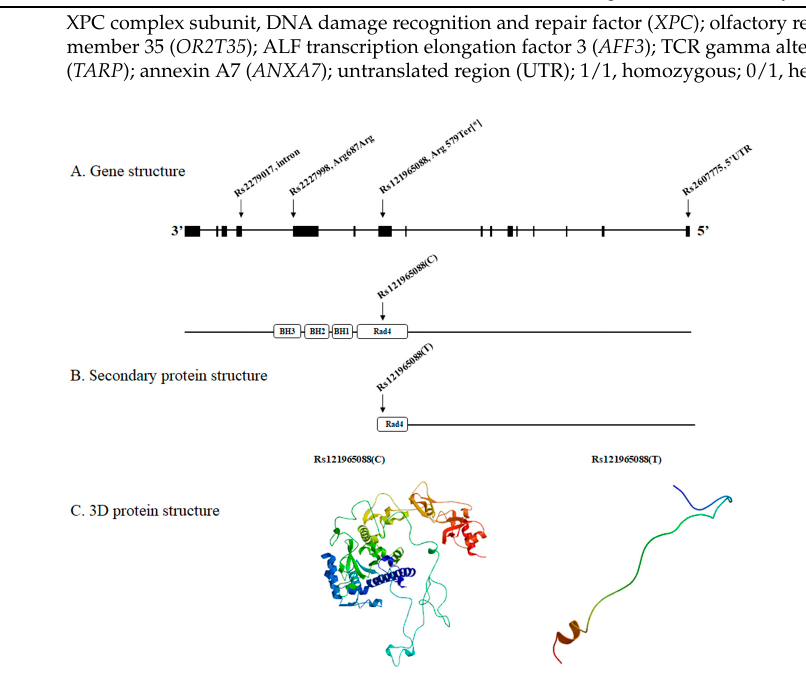
Figure 1. ( A ) The four XPC complex subunit, DNA damage recognition and repair factor ( XPC) variants (rs121965088, rs2227998, rs2279017 and rs2607775) of our patient located on the XPC gene. ( B ) The normal XPC protein is constructed by the consecutive translation of Rad4, BH1, BH2, and BH3 protein units. However, rs121965088 (*) generates a stop codon and results in premature termination during the Rad4 translation. ( C ) Consequently, a defective and misfolded XPC protein is produced. The resultant protein architecture is displayed by the protein 3D modeling program